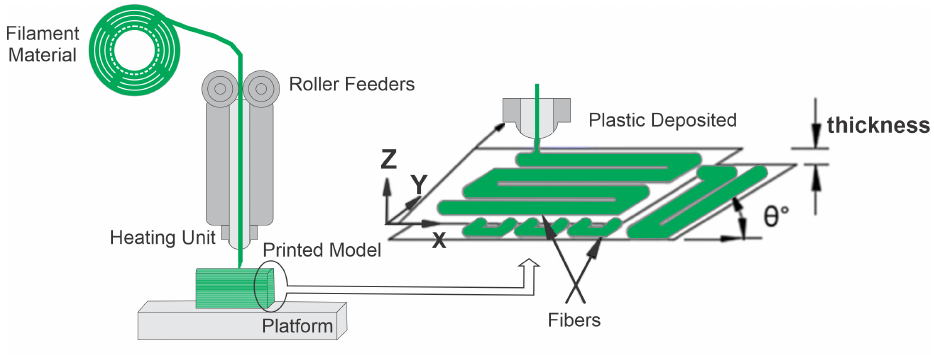
Figure 1. Three-dimensional printing